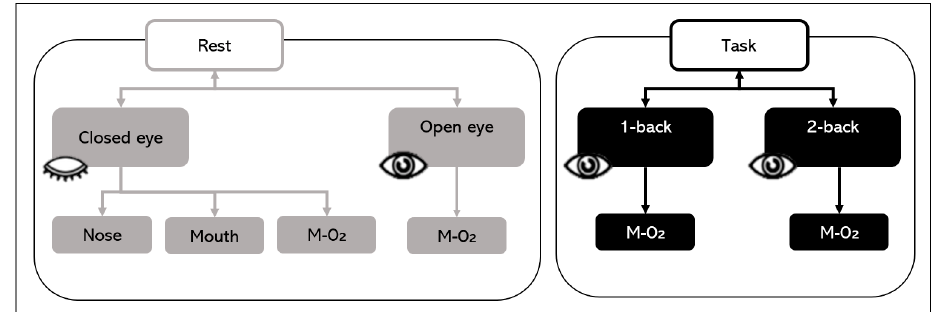
Figure 3. Experimental sessions. In the closed eyes rest state, nose and mouth breathing and mouth breathing with O 2 supply were tested. Mouth breathing with O 2 supply tasks (M-O 2 ) consisted of rest with closed and open eyes and 1-back and 2-back tasks.